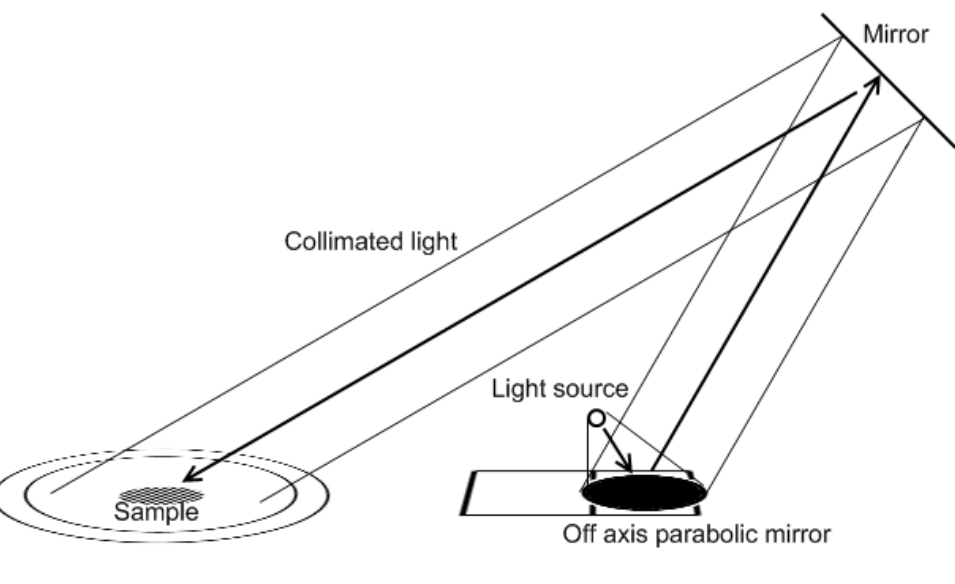
Figure 4. Illumination system. A 1,000-Watt QTH light bulb is positioned in the focal point of an off-axis paraboloid mirror (Ø 53 cm, f 47 cm). The collimated beam is pointed to the sample using a flat mirror. The illumination zenith angle can be varied freely between 20° and 70° by moving the flat